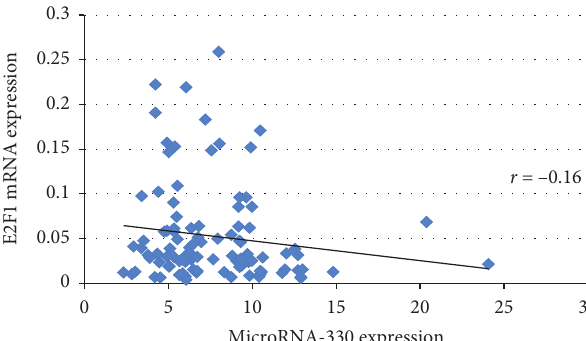
Table 5: Comparison of E2F1 mRNA expression with different risk factors among T2DM